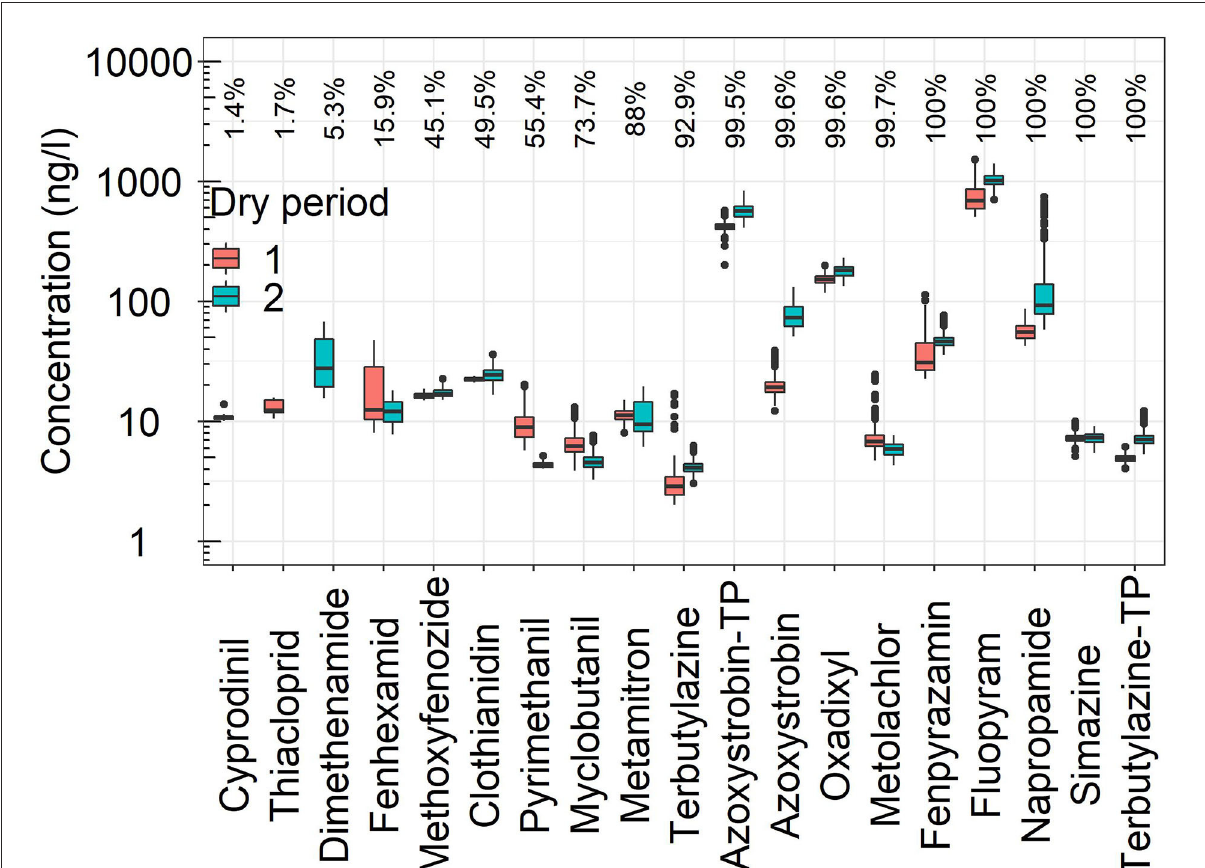
FIGURE3 Boxplots of concentration values measured with MS 2 Field grouped by compound and dry period. The first dry period spanned between June 2 nd to June 8 th , in salmon. The second dry period spanned between June 25 th and June 30 th , in light blue. Azoxystrobin-TP stands for azoxystrobin free acid and terbutylazine-TP stands for terbutylazine-desethyl. The percentages refer to detection percentages per compound over the dry periods. Data gaps due to the maintenance of MS 2 Field from 09:25 to 14:00 of June 3 rd , from 22:21 of June 4 th to 02:42 of June 6 th , and from 06:11 to 10:12 of June 27 th were not included. Concentrations below LOQ were